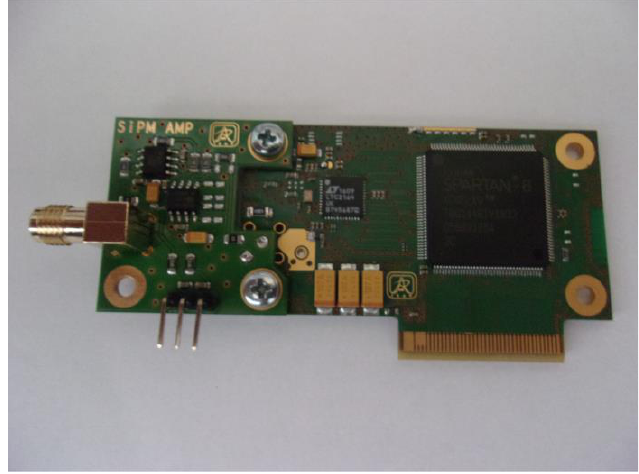
Fig. 3. The signal shaping module (left) attached to the ADC module (right). The front and back view on the 84-channel digitizer is shown in Fig. 4a and Fig. 4b.